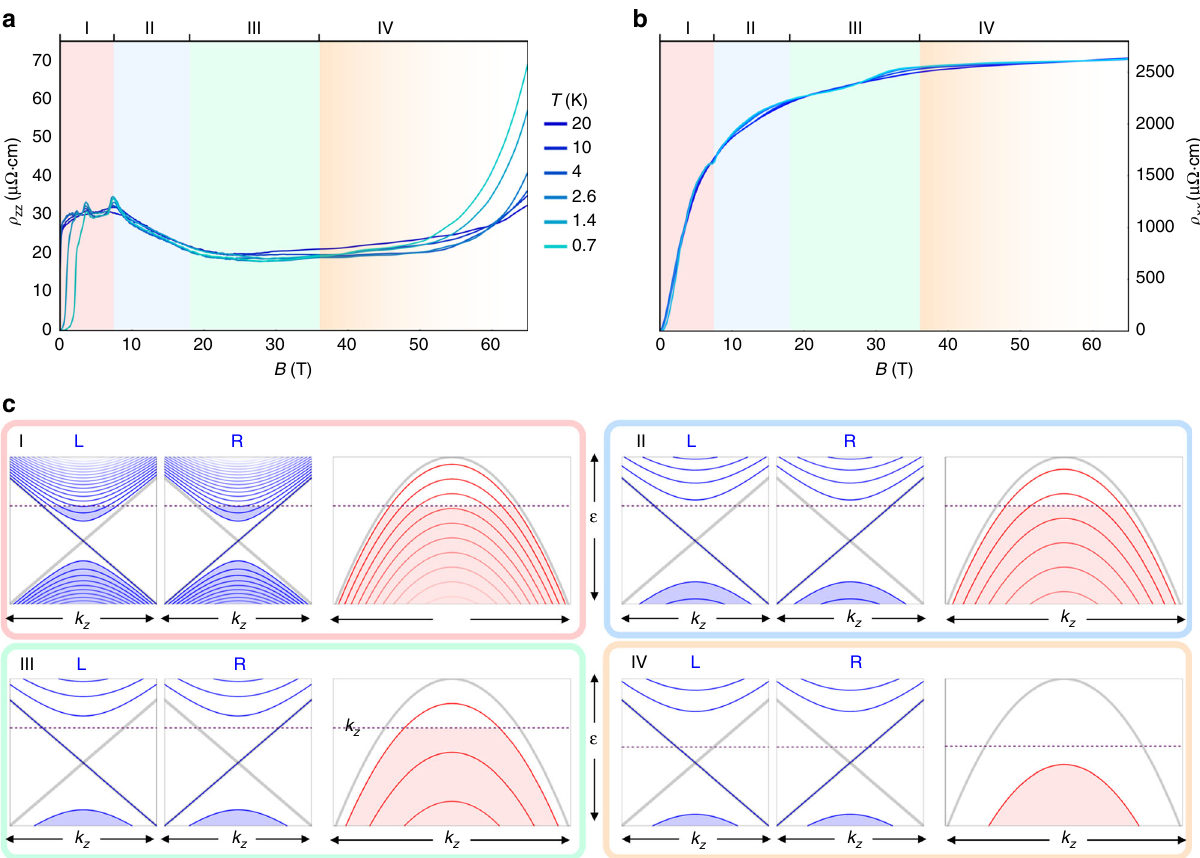
Fig. 2 The four distinct regimes of Landau level occupancy in TaAs up to 65 T. TaAs hosts two pairs of Weyl fermi surfaces (W1 and W2) with similar quantum limits for this fi eld orientation; one pair of Weyl nodes is shown here along with the trivial hole surface. Resistivity of TaAs at temperatures between 0.7 K and 20 K, for J jj B jj c ( a ) and for J ?ð B jj c Þ ( b ), from 0 to 65 T. c , Schematic of the Landau level (LL) structure and occupancy for the parabolic hole pockets (red lines) and Weyl electron pockets (blue lines). Gray curves are the B = 0 dispersions without LLs. Region I is from 0 to 7.5 T, where both hole and electron pockets exhibit quantum oscillations. Between 7.5 and 18 T (region II ) the electron pockets are in the n = 0 LL, whereas the hole pocket is still in the n = 1 LL. Between 18 and 36 T (region III ) the hole pocket is also in the n = 0 LL. At 36 T the last oscillation, corresponding to emptying the n = 0 LL of the hole pocket, can be seen in ρ xx . Above 36 T (region IV ) the only occupied states at the chemical potential are in the n = 0 LL of the Weyl electron pockets, and the chemical potential shifts to maintain overall carrier number ( n e − n h ). The faded region IV represents the mixing of the Weyl nodes